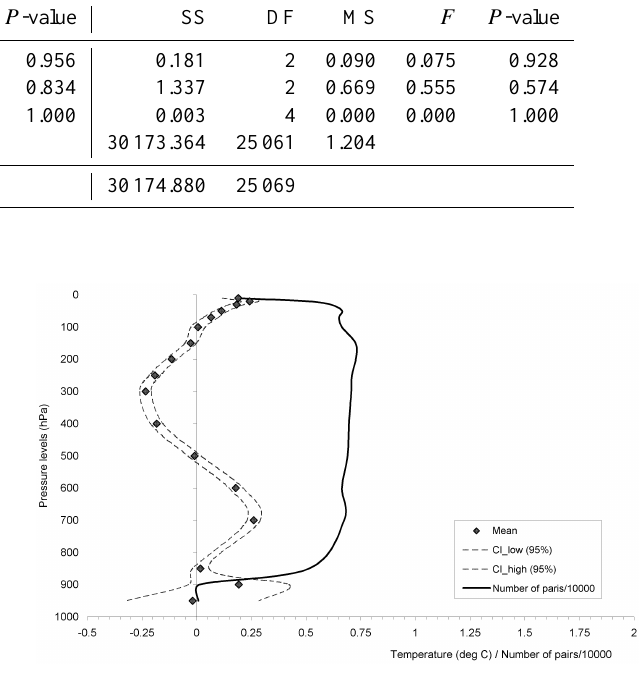
Fig. 2. CHAMP temperature profile comparison results (means, 95% confident levels and numbers of comparison pairs) at 16 dif- ferent pressure levels.